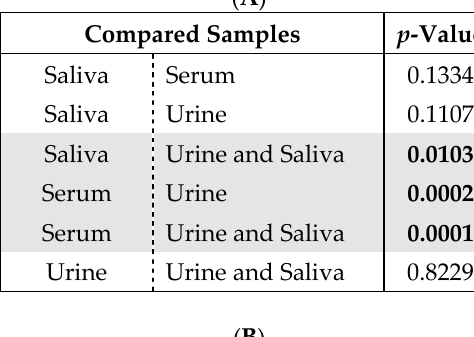
Figure 1. Impact of the samples on the probability to detect ZIKV. ( A ) Probability of detection (%) of ZIKV in serum, urine and/or saliva samples according to days since onset of symptoms and clinical signs (going from 1 to 25) (Table S3). Serum (black line), urine (blue line), saliva (red line), and urine and/or saliva samples (green line); ( B ) the significance of the difference between the curves in ( A ) is indicated by the p -value. The p -values in bold are considered as significant (<0.05). The significant sample comparisons are highlighted in